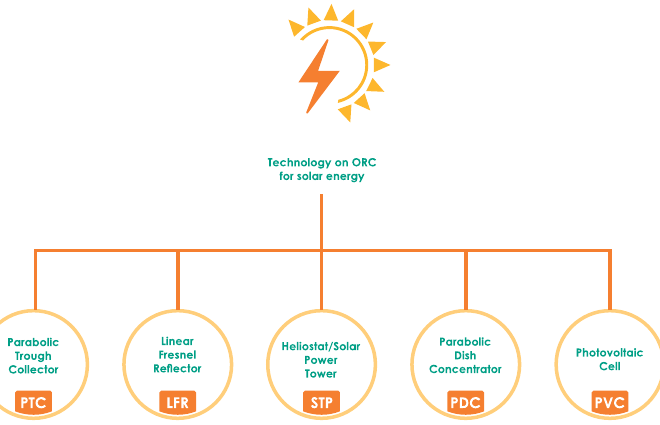
Figure 2. Technologies of ORC application for solar